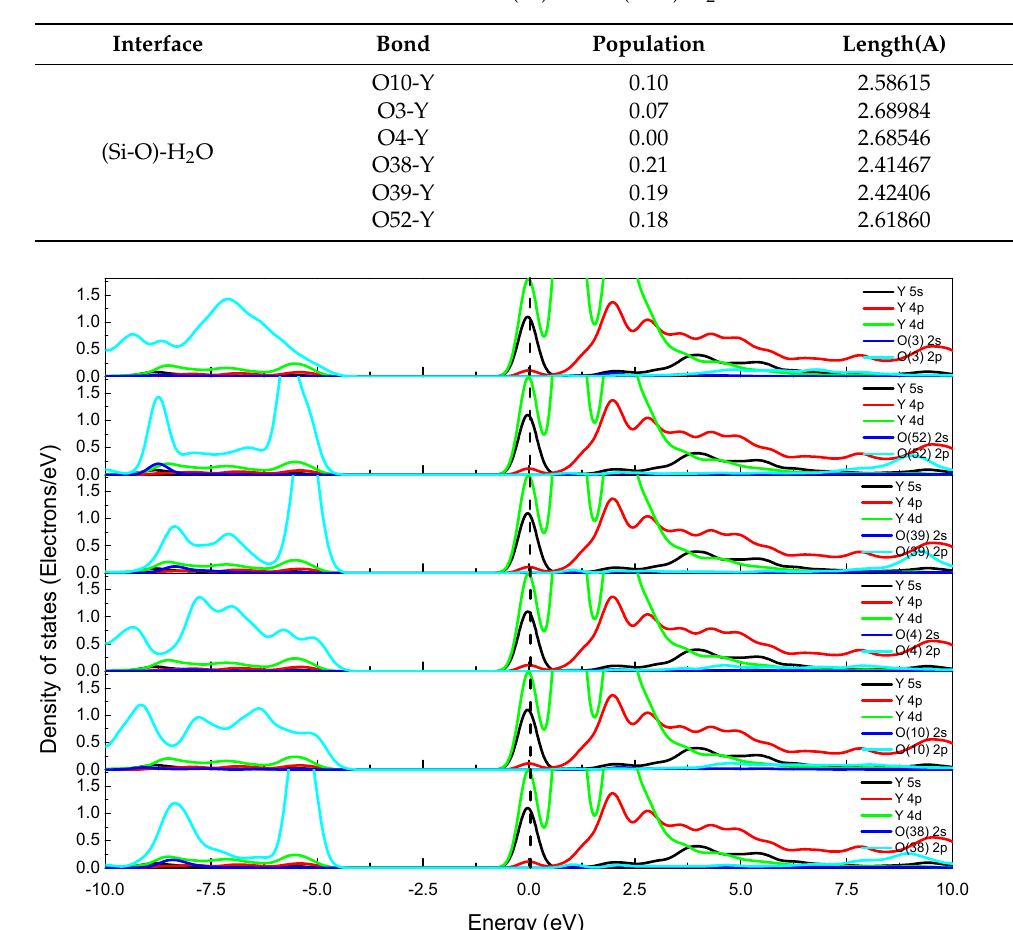
Figure 6. Partial density of states of Y and O in (Si-O)-H 2 O